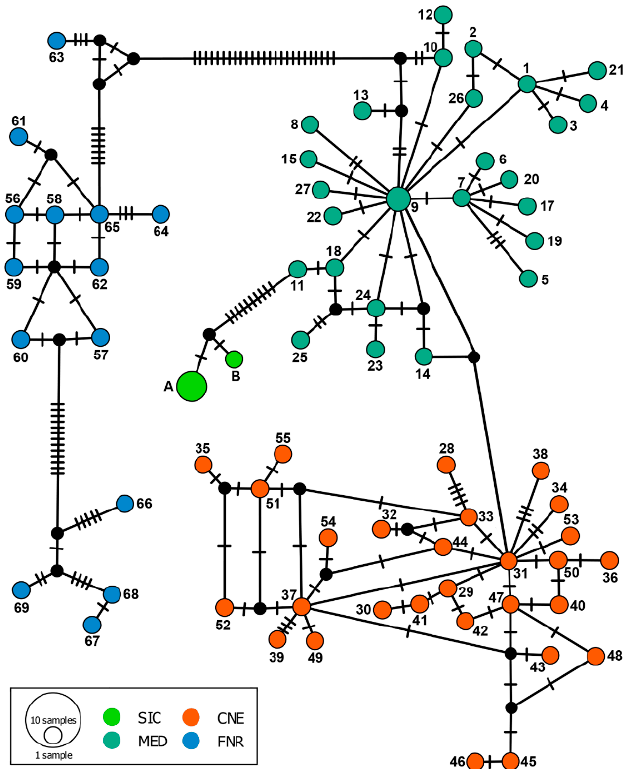
Figure 2. Median-joining haplotype network based on the “mtDNA I” dataset of Martes martes . Dashes indicate substitutions steps. Each circle represents a haplotype, and its size is proportional to its frequency. Numbers close to haplotypes refers to those reported by Ruiz-González et al. [15]. Novel Sicilian haplotypes are coded as “A” (A.N.: OP374121—OP374123) and “B” (A.N.: OP374124). Colours refer to phylogroups shown in Figure 1. (Sicily (SIC), Mediterranean (MED), Central– Northern European (CNE), Fennoscandian–Russian (FNR) phylogroups).